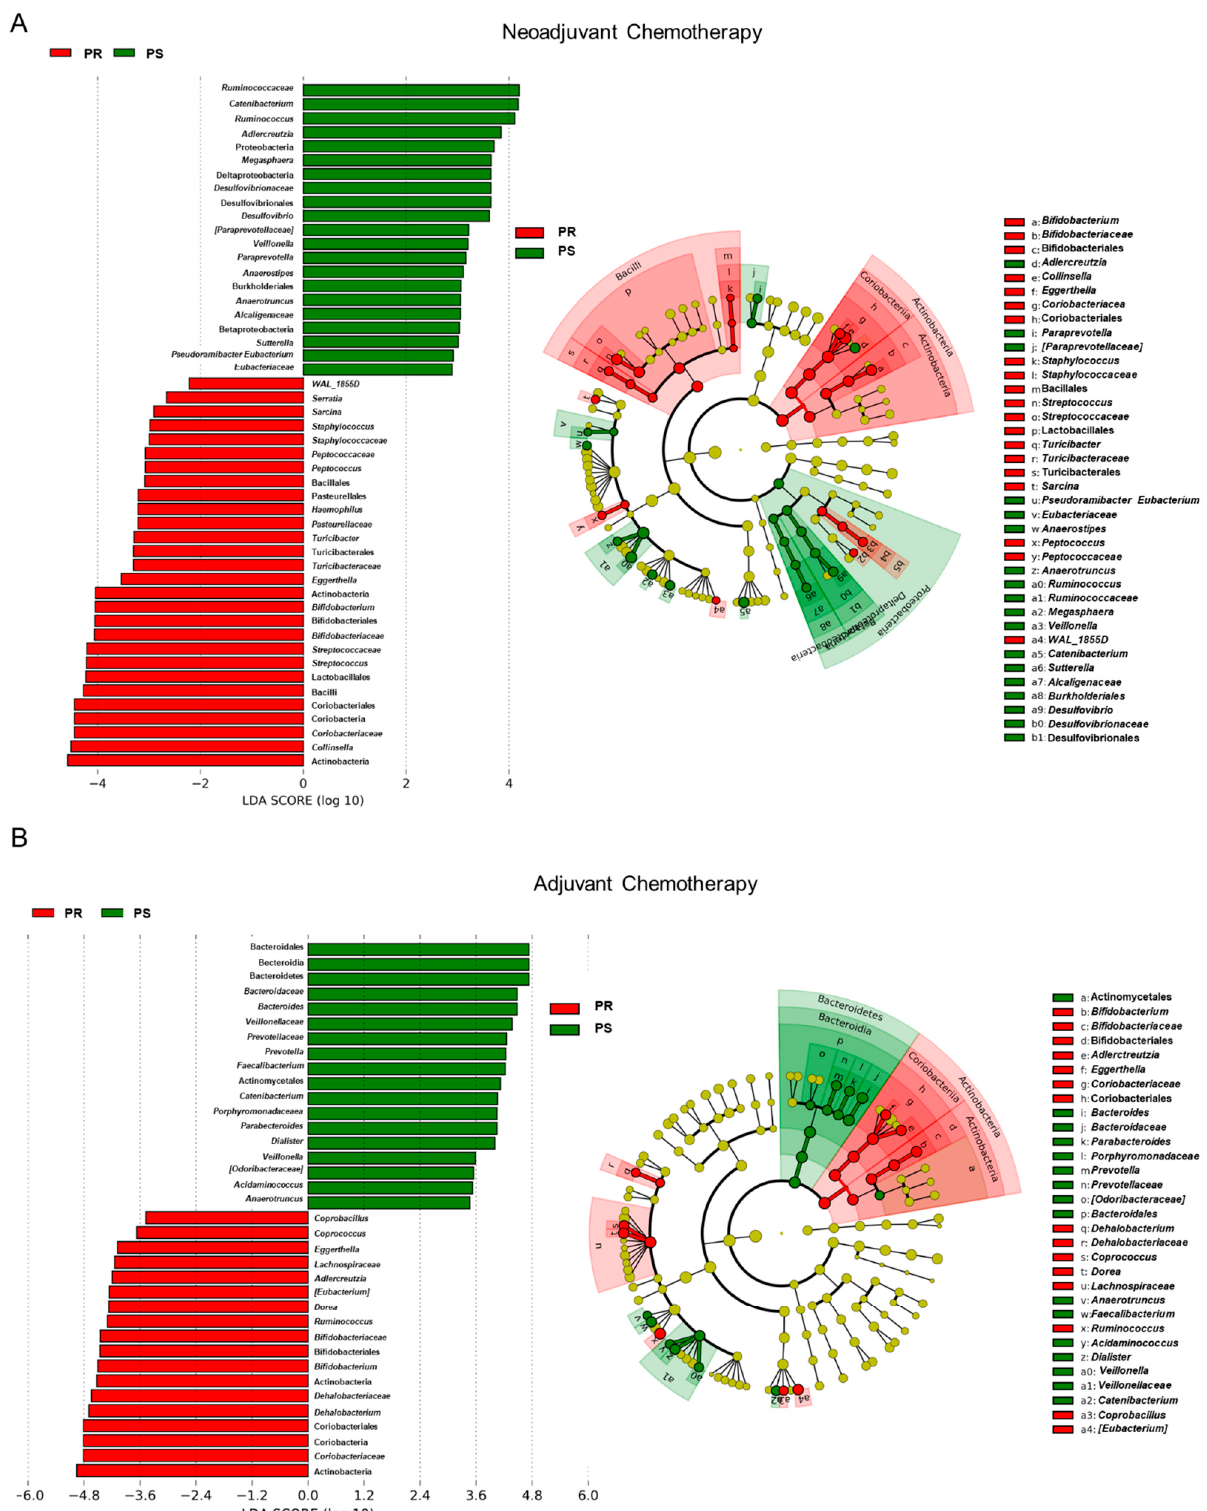
Figure 5. Potential taxonomic signatures of therapeutic response in EOC patients receiving neoadjuvant or adjuvant chemotherapy. Differentially represented taxa between platinum-sensitive (i.e., PS) and platinum-resistant (i.e., PR) EOC patients receiving neoadjuvant ( A ) or adjuvant ( B ) chemotherapy were identified by linear discriminant analysis (LDA) effect size (LEfSe) analysis. Left, LDA scores; right, cladograms. The logarithmic threshold for discriminative features was set to 2.0. See also Figure S5.